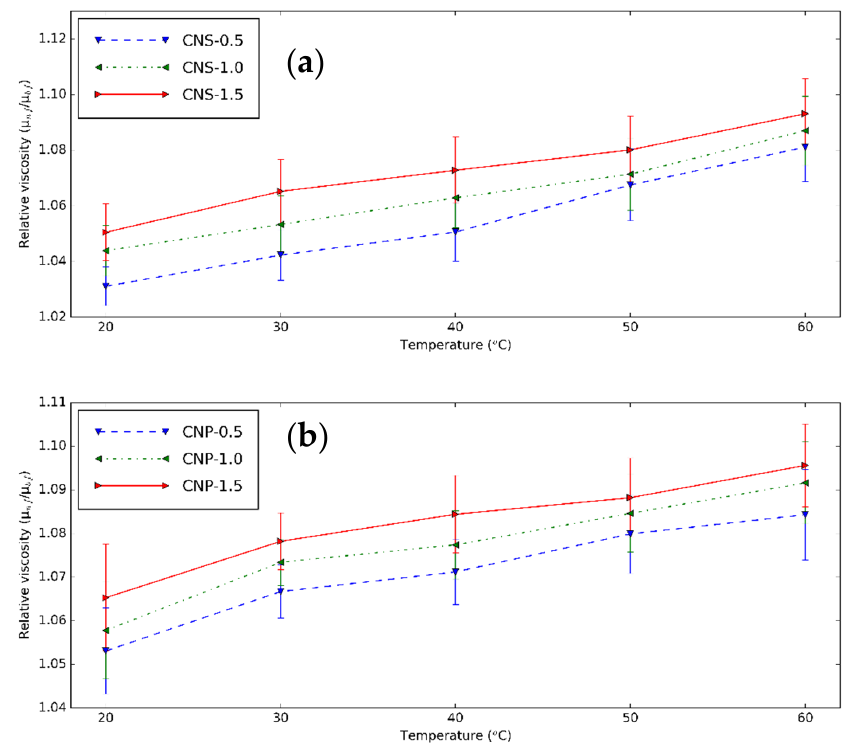
Figure 9. Relative viscosity–temperature diagram of ( a ) CNS and ( b ) CNP nanofluids for different concentration at different temperatures.